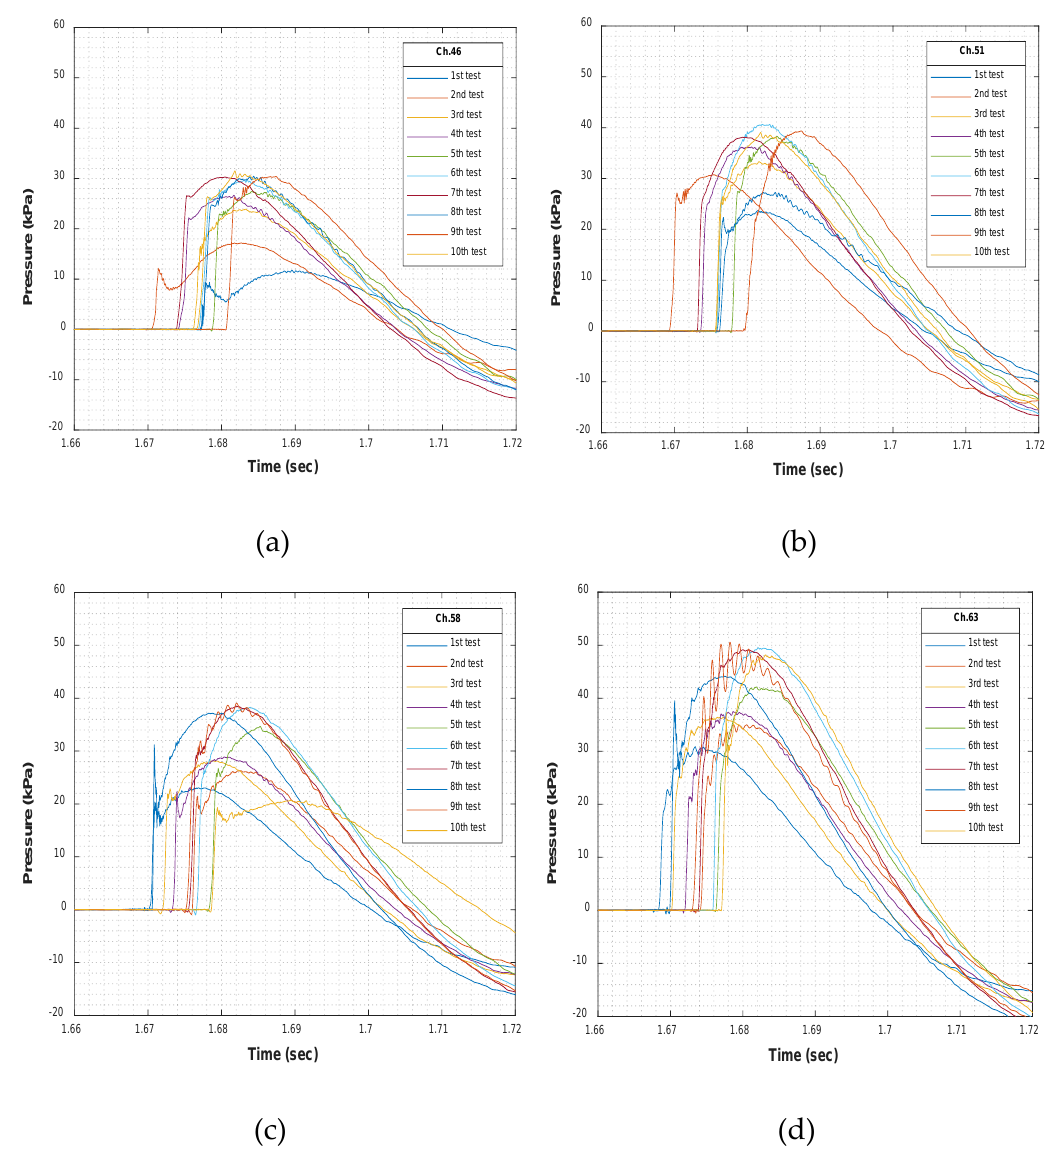
Figure 17. Time Histories of the Pressure Measured at Four Different Channels for ROLL (Wet): ( a ) Channel 46, ( b ) Channel 51, ( c ) Channel 58 and ( d ) Channel 63. For the SWAY, where bubbles were abundantly generated, high-frequency oscillation occurred as shown in Figure 16. Figures 18–21 show the results of a FFT frequency analysis of the data in Figure 16. The FFT analysis was performed twice by dividing the 20 total runs of experimental data into 10 each depending on the experimental temperature. Both FFT results showed a first peak caused by a major impact at 6–7 Hz and a second peak at 150–160 Hz. This result was judged to arise from air pockets observed in the flow visualization and from the oscillation of the many bubbles produced immediately after the impact. The distribution of local pressure was determined to be significantly different depending on the experiments because of the different microscopic flow behaviors.